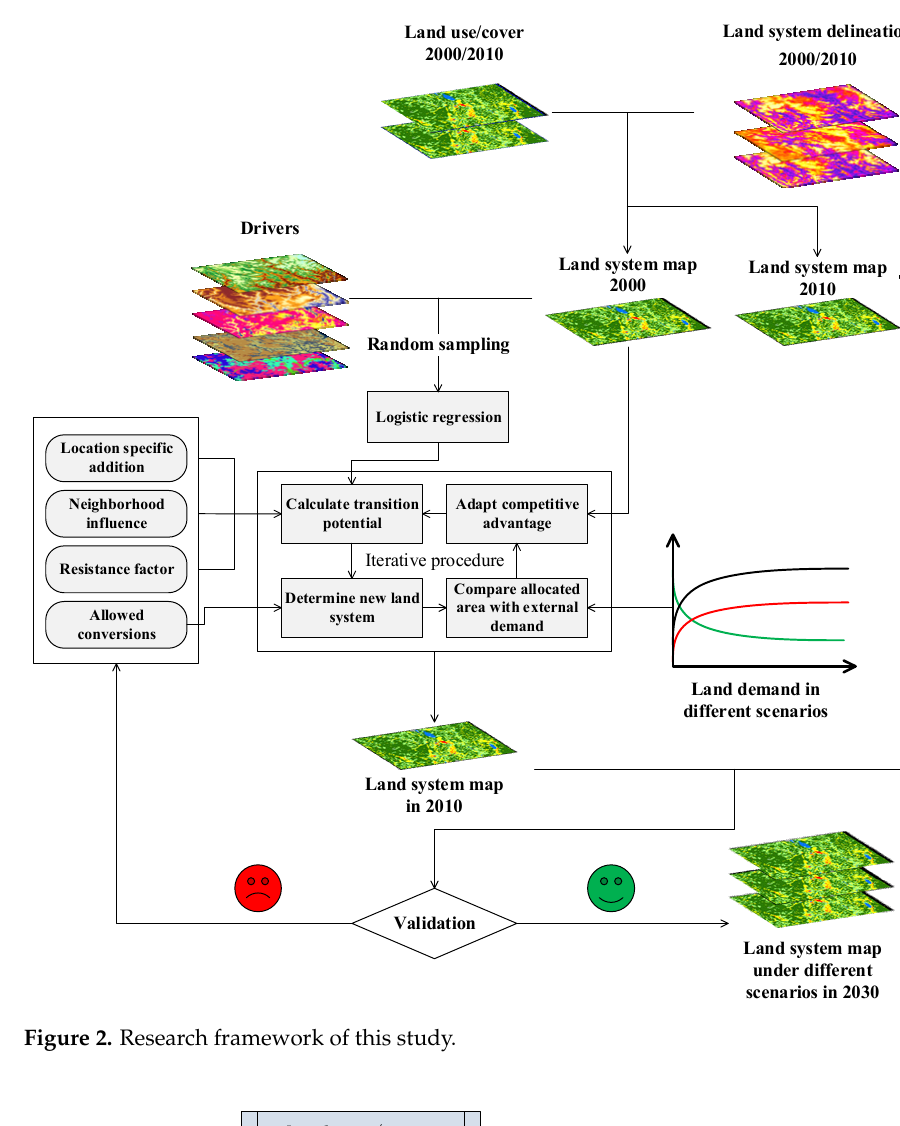
Land 2021 , 10 , 528